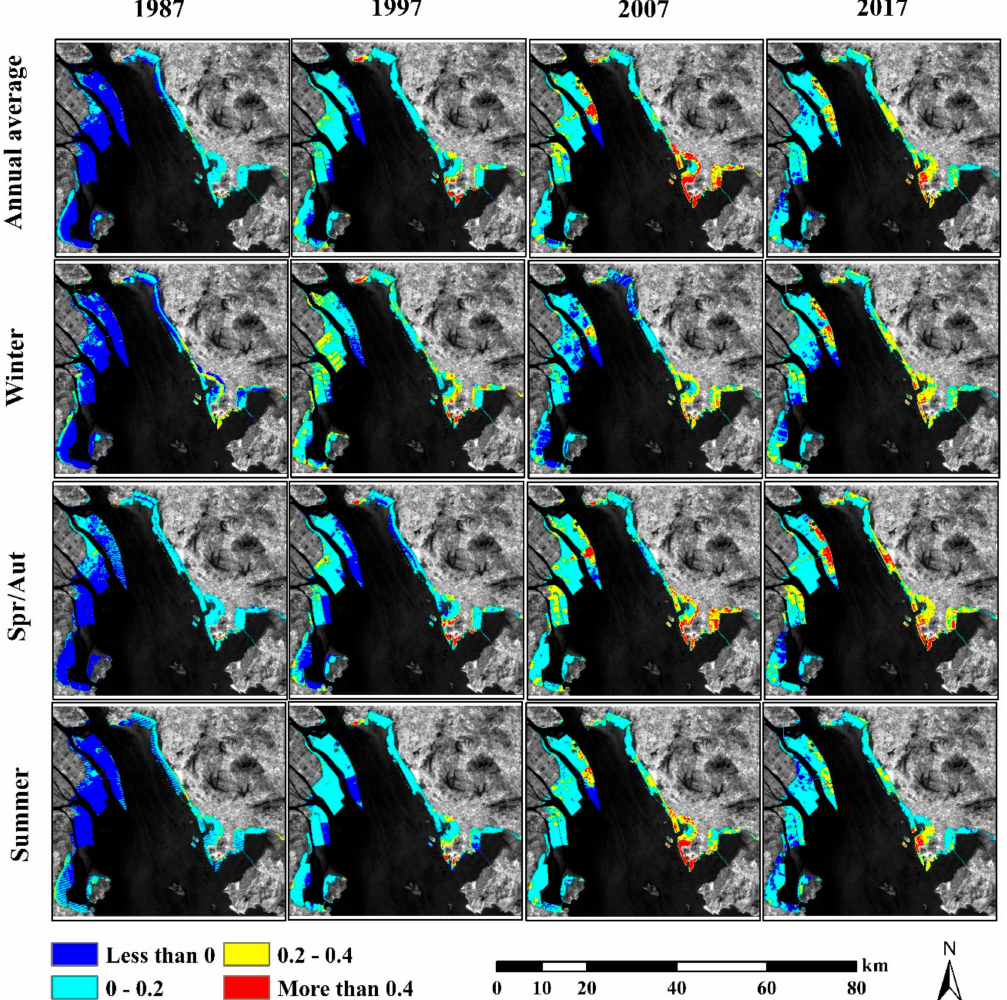
Figure 9. Distribution of annual and seasonal LSTn over the study